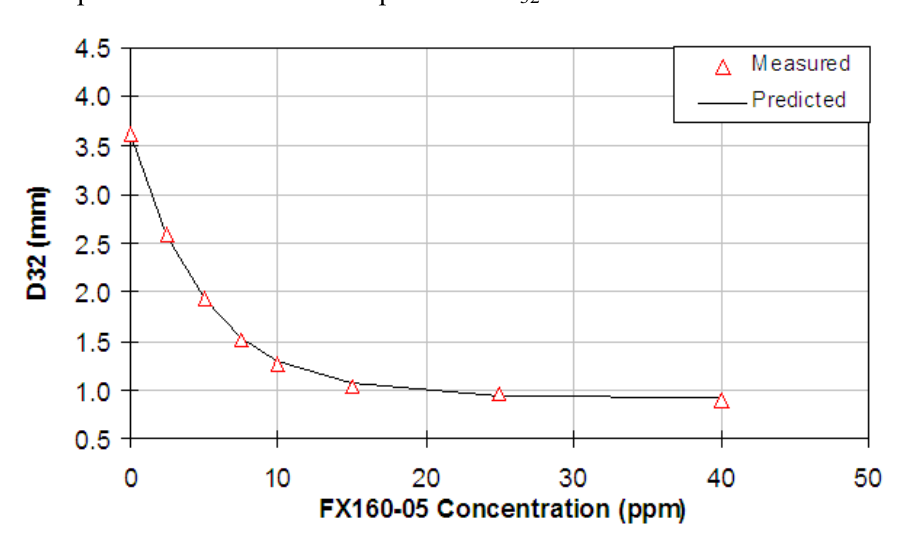
Figure 14. Comparison of measured and predicted D